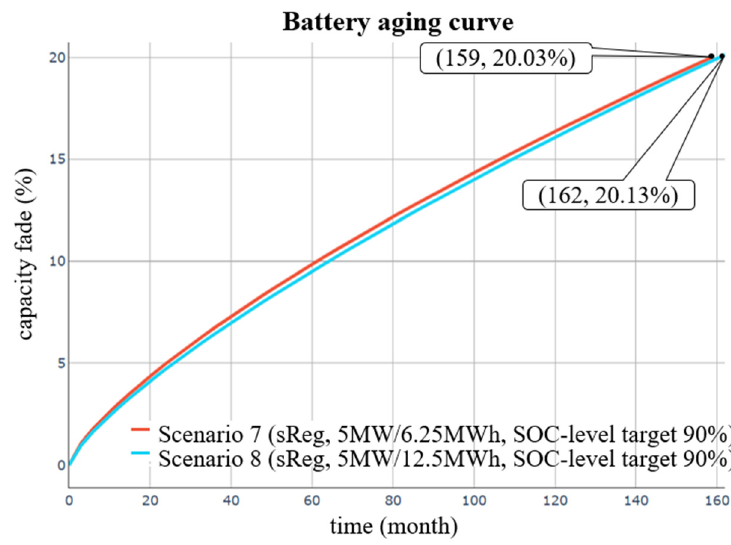
Figure 18. The result under different C-rates (sReg).